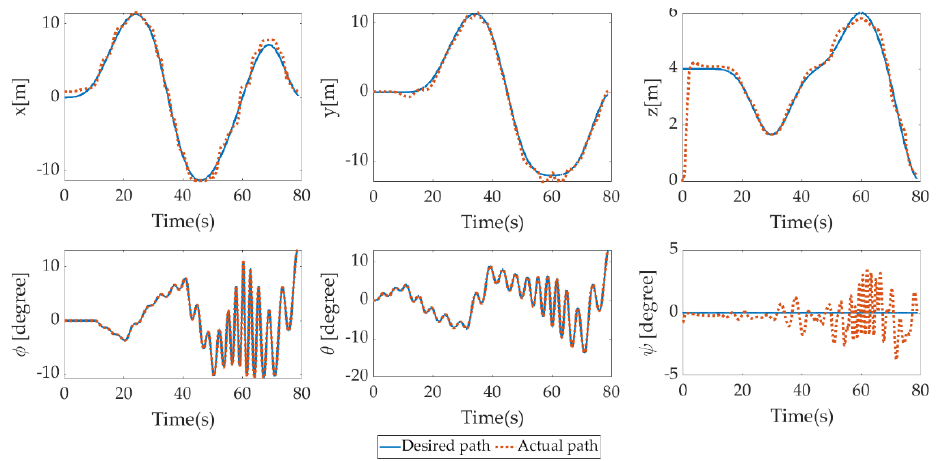
Figure 19. Simulation result of the optimized configuration in tolerating actuator 1 failure and performing maneuvers.